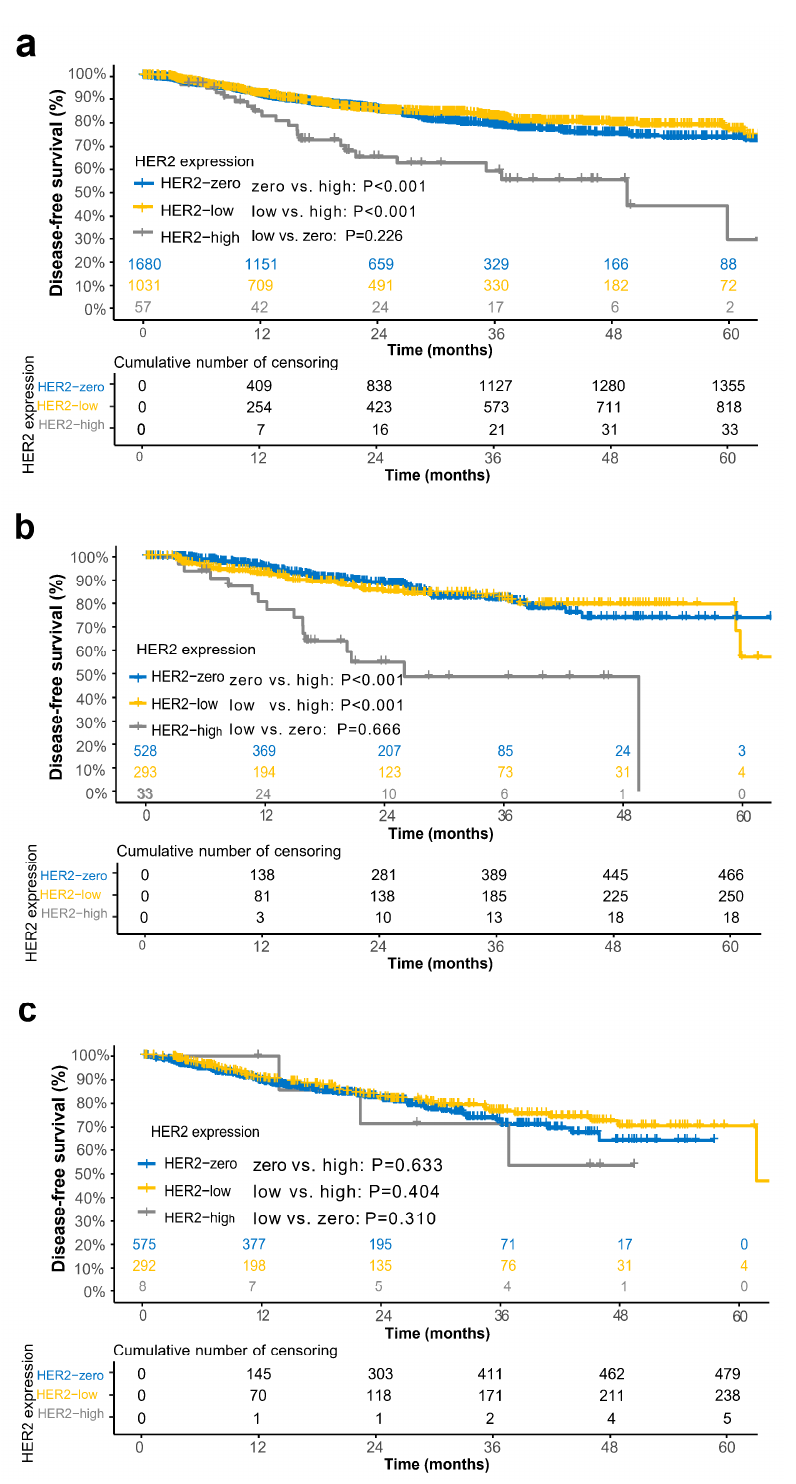
Figure 4. Kaplan-Meier survival analysis for disease-free survival. Comparison of HER2-zero, HER2-low and HER2-high groups for the overall cohort, ( a ) for RAS/BRAF wild-type cohort, ( b ) and RAS/BRAF mutation cohort ( c ). p values are from the Cox proportional hazards regression model.